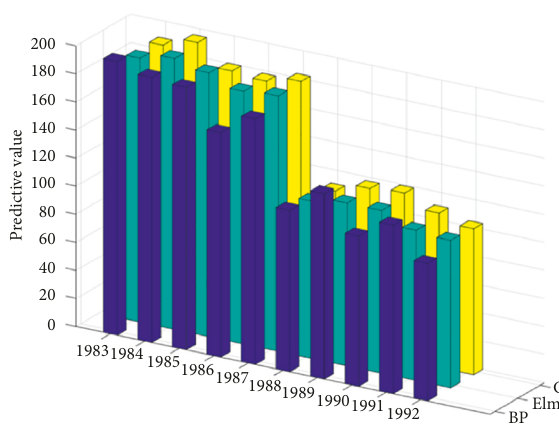
Figure 7: Fitting diagram of total output in historical